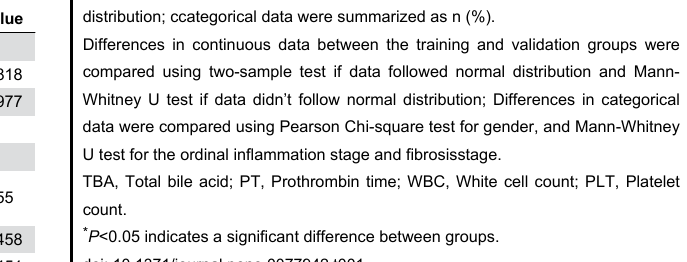
Table 2. Correlation analysis of inflammation stages and fibrosis stages with subjects’ demographic and clinical characteristics.